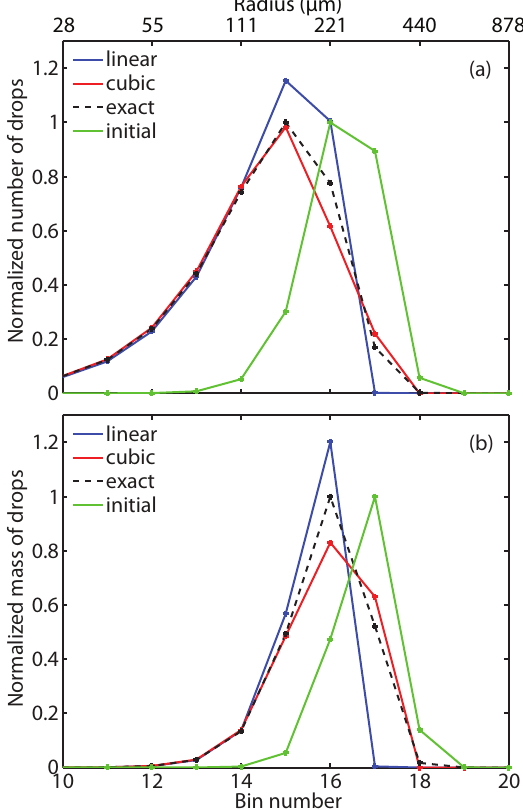
Fig. 2. L 1 errors in (a) number and (b) mass of drops of the so- lutions at 50 min obtained by the linear and cubic schemes in the evaporation problem. The errors are plotted in logarithmic